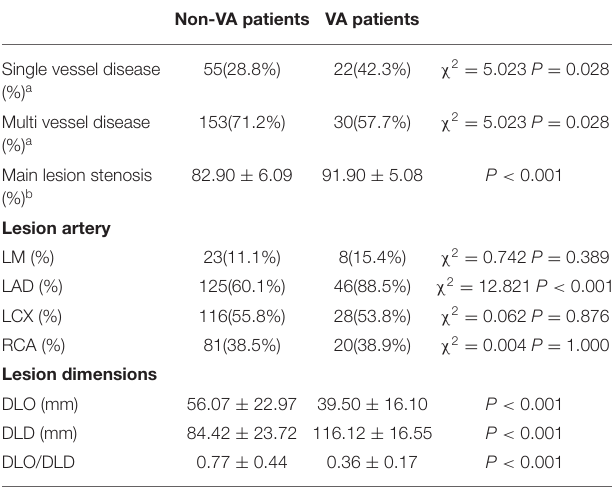
TABLE 2 | Lesion artery characteristics of patients with and without